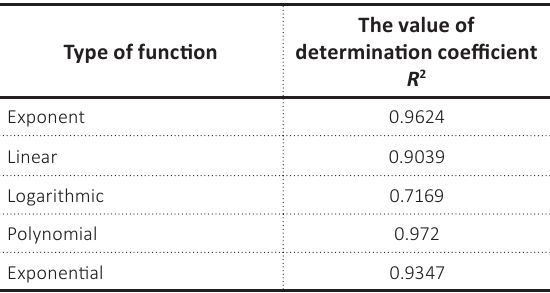
Table 1. Interim calculations to determine the type of growth curve for the volume of gross premiums of the voluntary health insurance